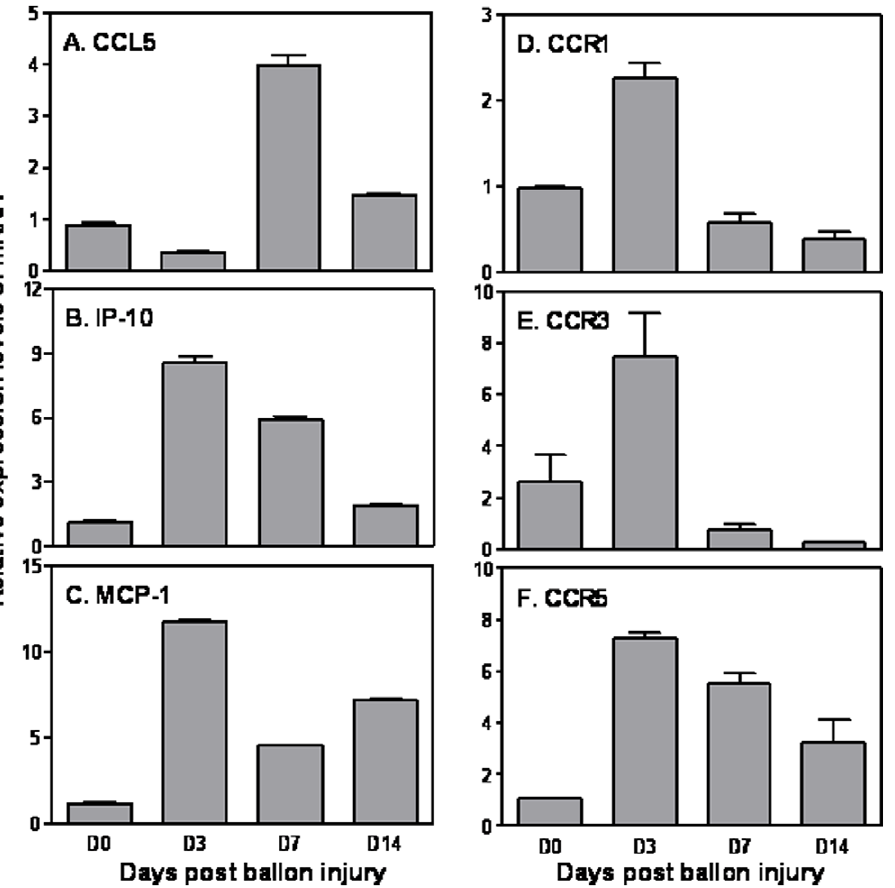
Figure 1. Kinetic expression of chemokines in aorta after balloon injury. Total RNA was extracted from aorta and used for real time quantitative PCR (qRT-PCR) measurement of CCL5 (A), IP-1 (B) and MCP-1 (C) mRNA expression as well as CCR1 (D), CCR3 (E) and CCR5 (F) mRNA expression. qRT-PCR data were normalized relative to GAPDH mRNA expression levels in each respective sample and further normalized to the results from the un-treated aorta, which was set as 1. Results shown are mean plus SD of three to four independent experiments.